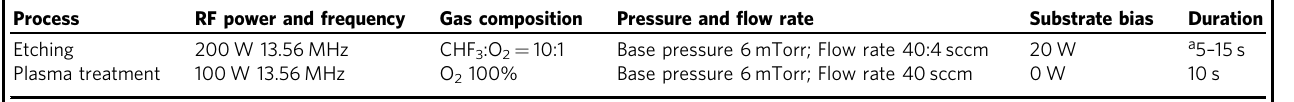
Table 1 RIE conditions used in the contact